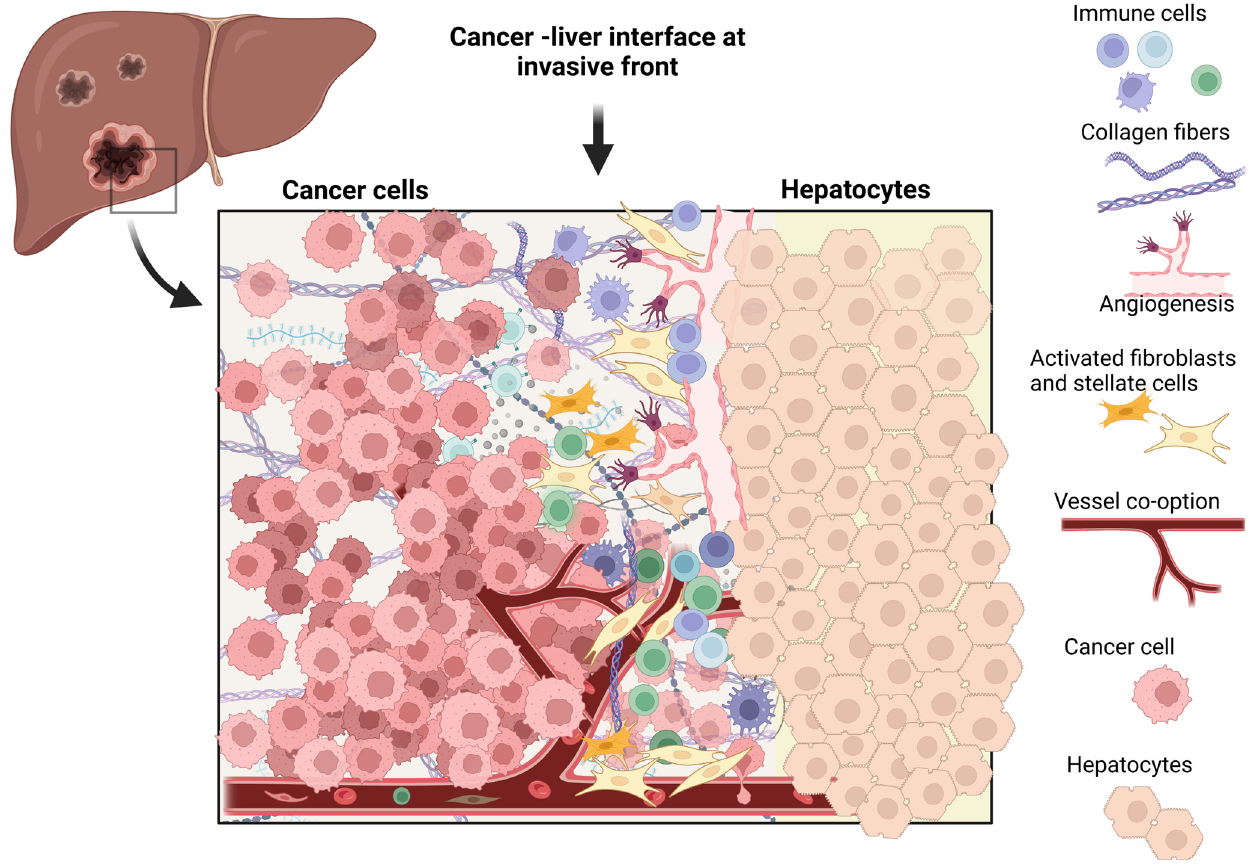
Figure 3. The tumor immune microenvironment in colorectal liver metastasis. The interface between tumor cells and the hepatocytes in colorectal liver metastasis, illustrating components of the tumor- immune microenvironment and other mechanisms that have been studied in the context of different histopathological growth patterns, including angiogenesis, vessel co-option, immune cells, and activated stromal elements. For a detailed description, please refer to the main body of the text. Created with Biorender.com.